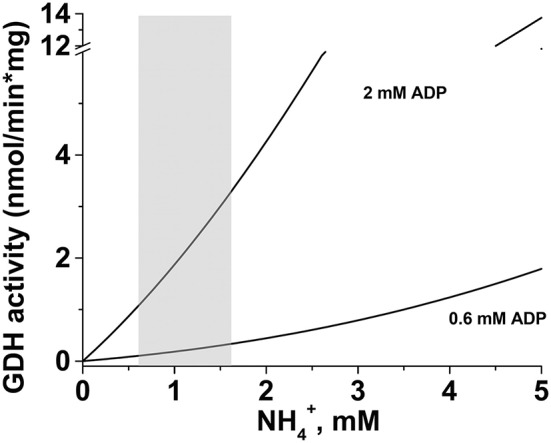
Simulation of GDH activity in the presence of modulators. For estimation of the GDH activity under physiological conditions, Equation 2 was used. The kinetic parameters at pH 7.5 were taken from Tables 2, 3, and concentrations of substrates and modulators were taken from Table 4. The gray-shaded area represents the range of NH4+ concentrations that can be found in cancer mitochondria when glutamine is oxidized (Table 4). In silico analysis was performed in the OriginPro 8 software with the following concentration values: 2.1 mM 2-oxoglutarate, 0.6 or 2 mM ADP, 0.14 mM GTP, and 1.2 mM NADPH.